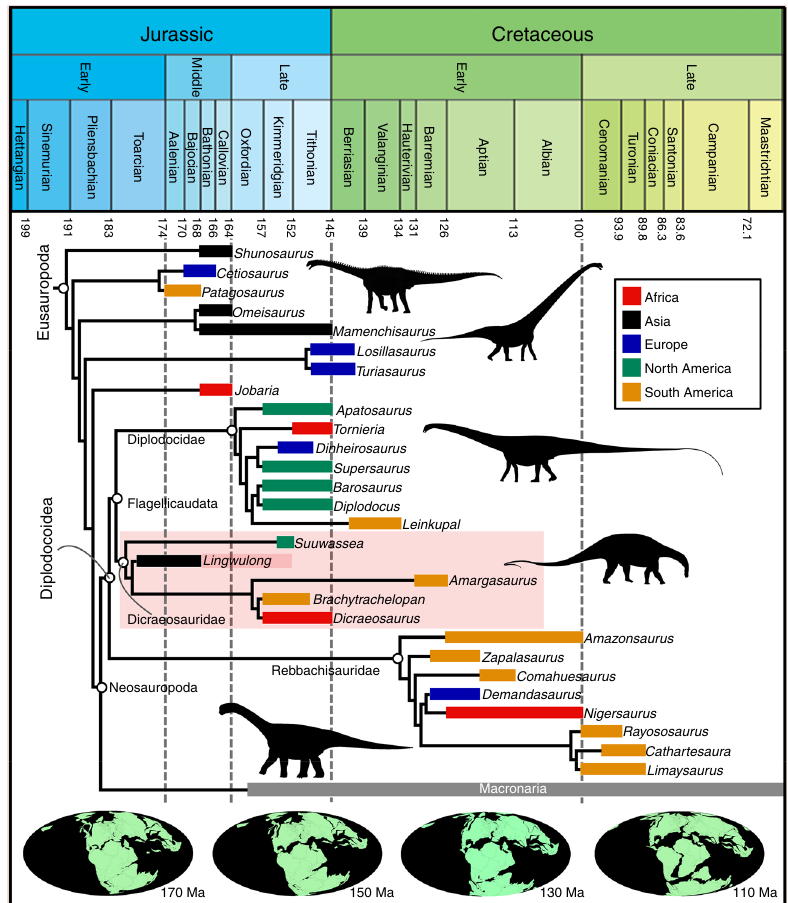
Fig. 3 Time-calibrated evolutionary tree for Eusauropoda. Agreement subtree produced in TNT, with additional diplodocid taxa incorporated (see Supplementary Note 4). All macronarian taxa have been combined into a single lineage, and non-sauropod sauropodomorphs have been removed, in order to enhance clarity (see Supplementary Fig. 13 for the full version of this tree). Silhouettes of dinosaurs drawn by Scott Hartman, Mike Taylor, and Mathew Wedel, and available at Phylopic (http://phylopic.org/) under a Creative Commons Attribution 3.0 Unported license (https://creativecommons.org/ licenses/by/3.0/). Global paleogeographic reconstructions from the Paleobiology Database